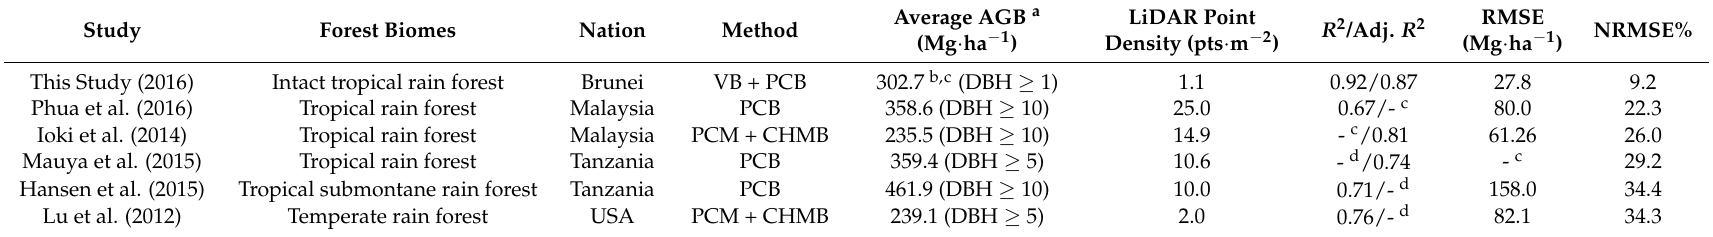
Table 5. Comparison of preceding plot-level AGB estimation